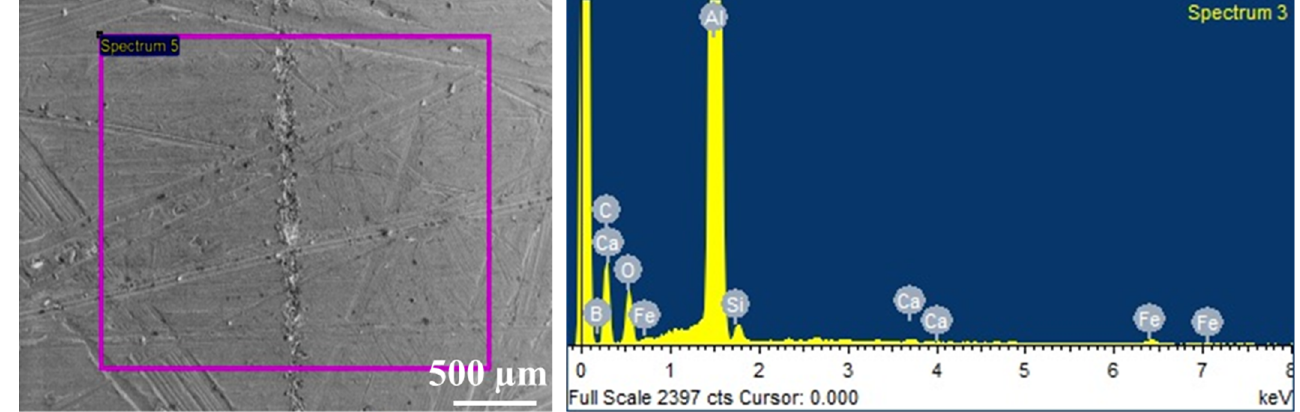
Figure 14. SEM with EDAX of Al-MMC in the weld nugget region.